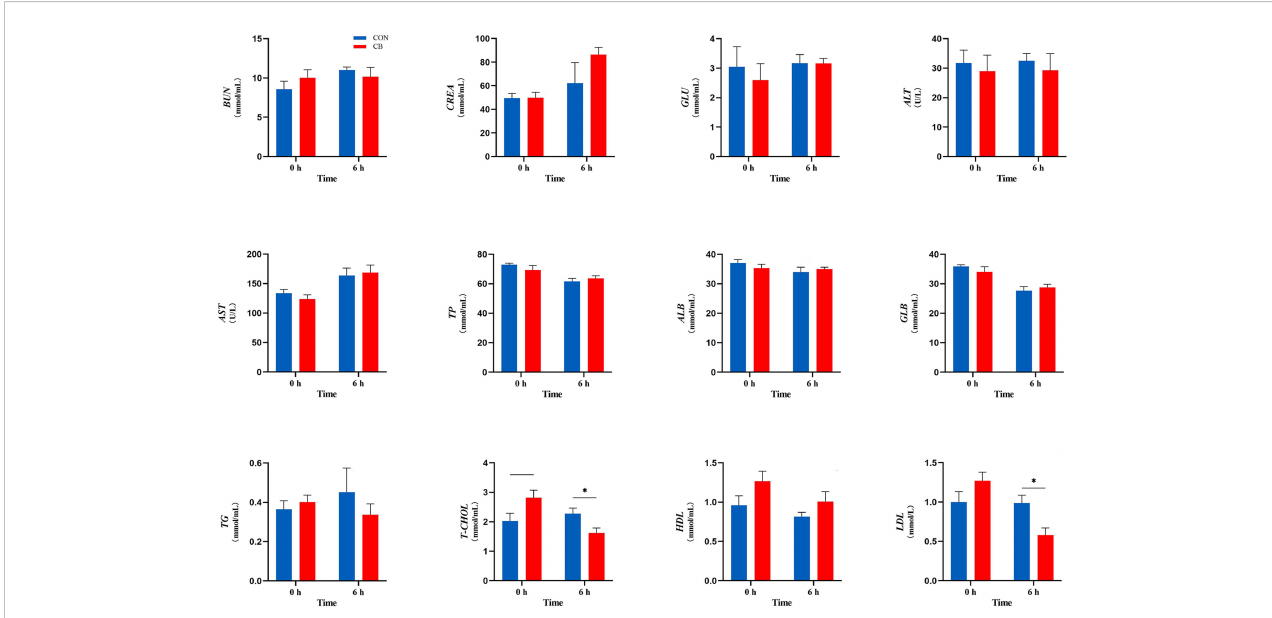
FIGURE 2 Measurement of plasma biochemical parameters at 0 h and 6 h. BUN, blood urea nitrogen; CREA, creatinine; GLU, glucose; ALT, alanine transaminase; AST, aspartate transaminase; TP, total protein; ALB, albumin; GLB, globulin; TG, triglyceride; T-CHOL, total cholesterol; HDL, high-density lipoprotein; LDL, low-density lipoprotein. * P < 0.05 , — 0.05< P < 0.10 between